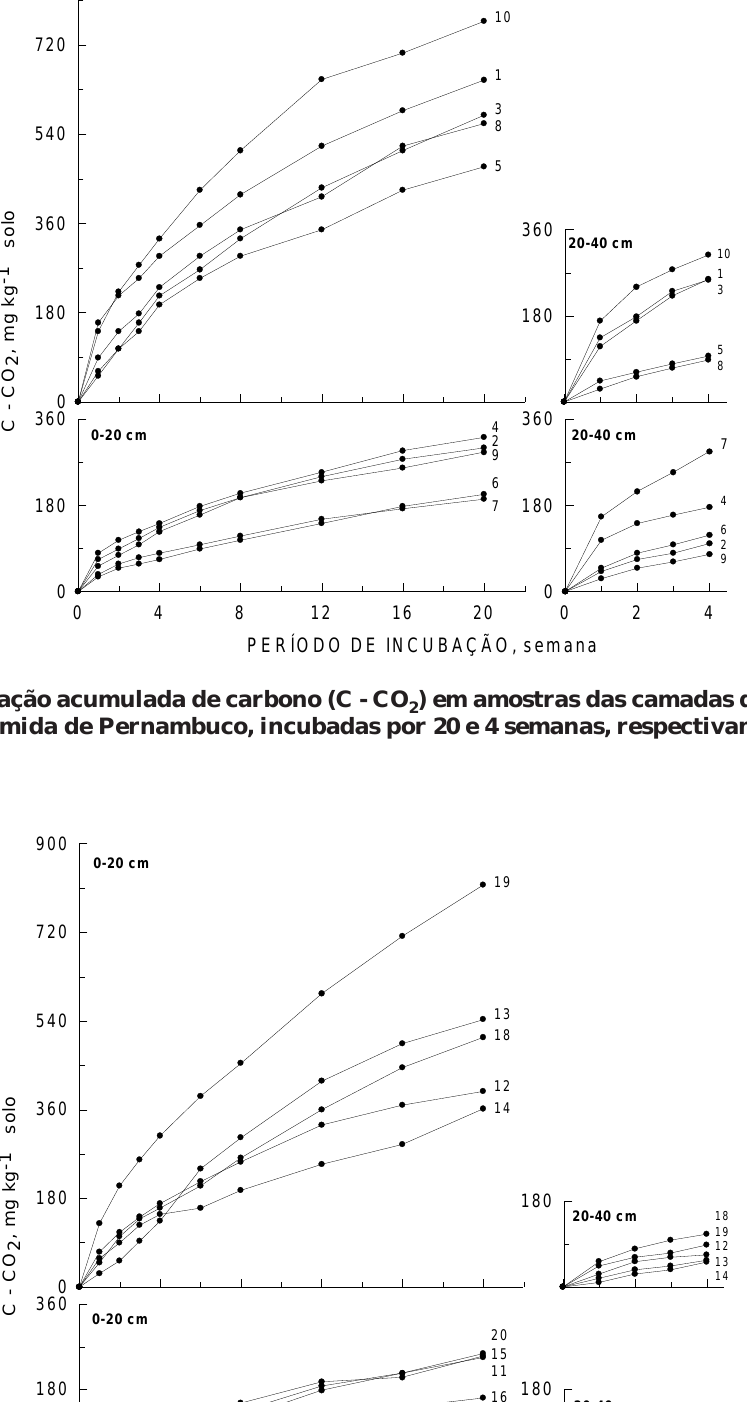
) em amostras das camadas de 0-20 e 20-40 cm de 2